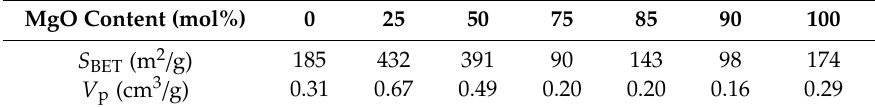
Table 1. Textural properties of binary M1/SiO 2 mixed oxides and of the precursors M1 and SiO 2 . MgO Content (mol%) 0 25 50 75 85 90 100 S BET (m 2 /g) 185 432 391 90 143 98 174 V p (cm 3 /g) 0.31 0.67 0.49 0.20 0.20 0.16 0.29